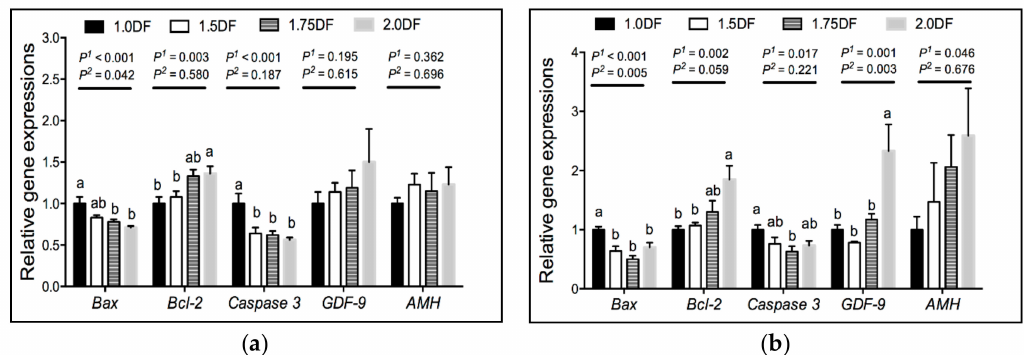
Figure 1. E ff ects of dietary fiber intake levels on the gene expressions of ovarian tissues in gilts on day 30 of the experiment ( a ) and on the 19th day of the 3rd estrous cycle ( b ). Data are expressed as means ± SE; n = 6; DF, dietary fiber; P 1 denotes linear e ff ects; P 2 denotes quadratic e ff ects; a,b denotes p < 0.05.